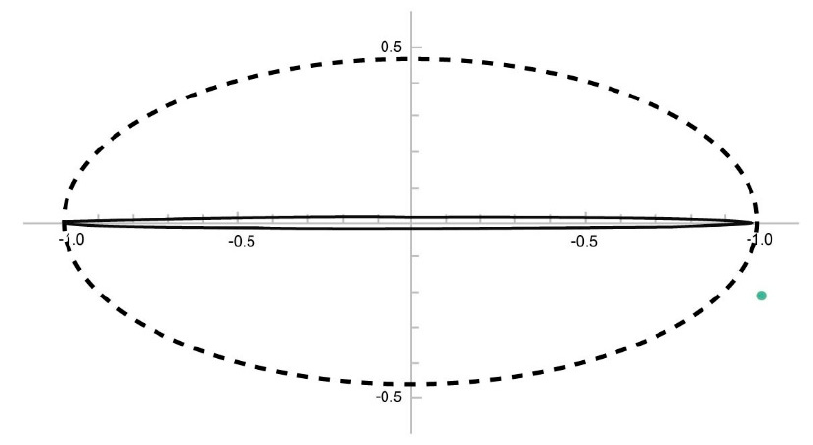
Figure 5. The tor.